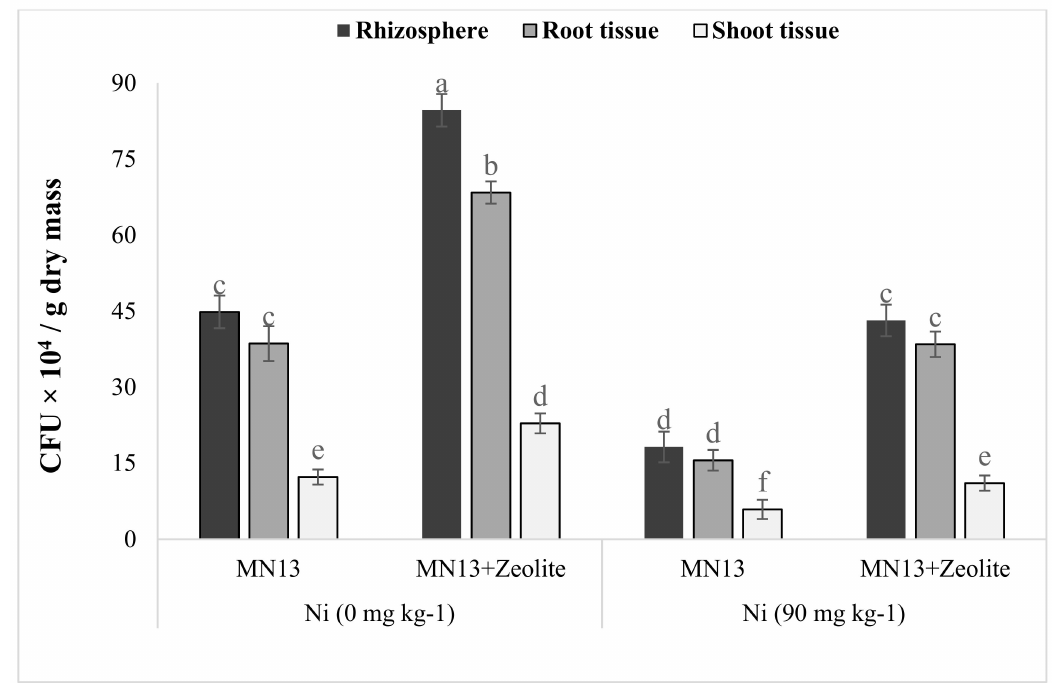
Figure 3. Persistence of the endophytic bacterial strain MN13 in the rhizosphere and presence in root and shoot extracts of sesame grown in Ni stressed soil conditions. Bars sharing the same letters do not di ff er significantly with each other at p < 0.05. The values are mean ± S.D. ( n = 4). MN13: Caulobacter